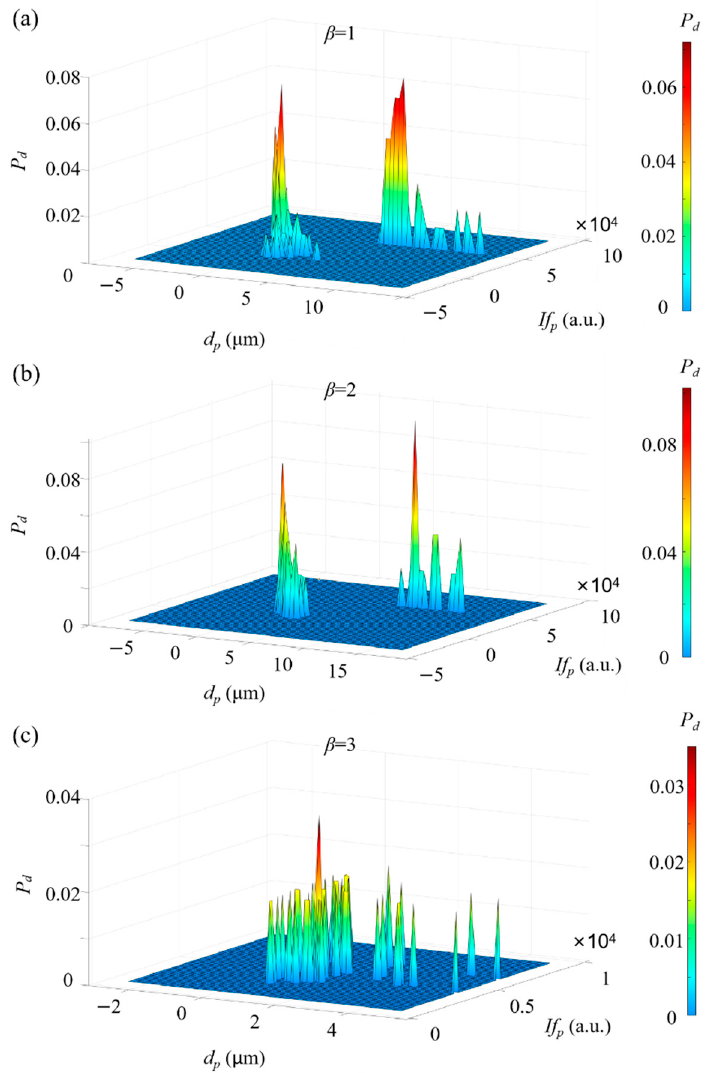
Figure 12. Two-dimensional probability density distribution of a mixed solution. ( a ) β = 1; ( b ) β = 2; Figure 12. Two - dimensional probability density distribution of a mixed solution. ( a ) 𝛽 = 1; ( b ) 𝛽 = 2; ( c ) 𝛽 = 3. ( c ) β = 3.